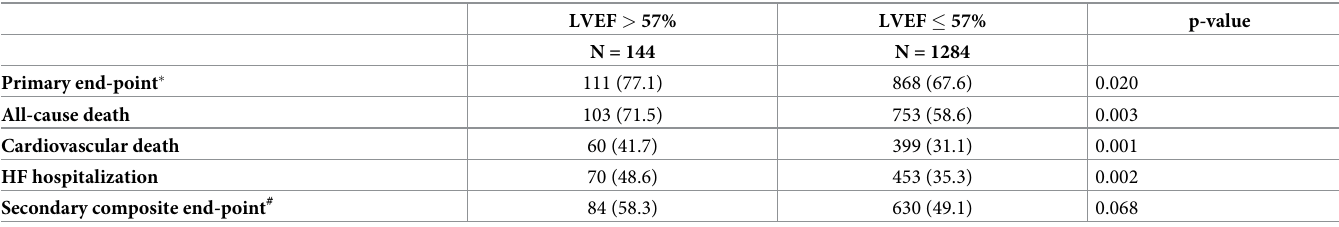
Table 2. End-points distribution based on LVEF group.